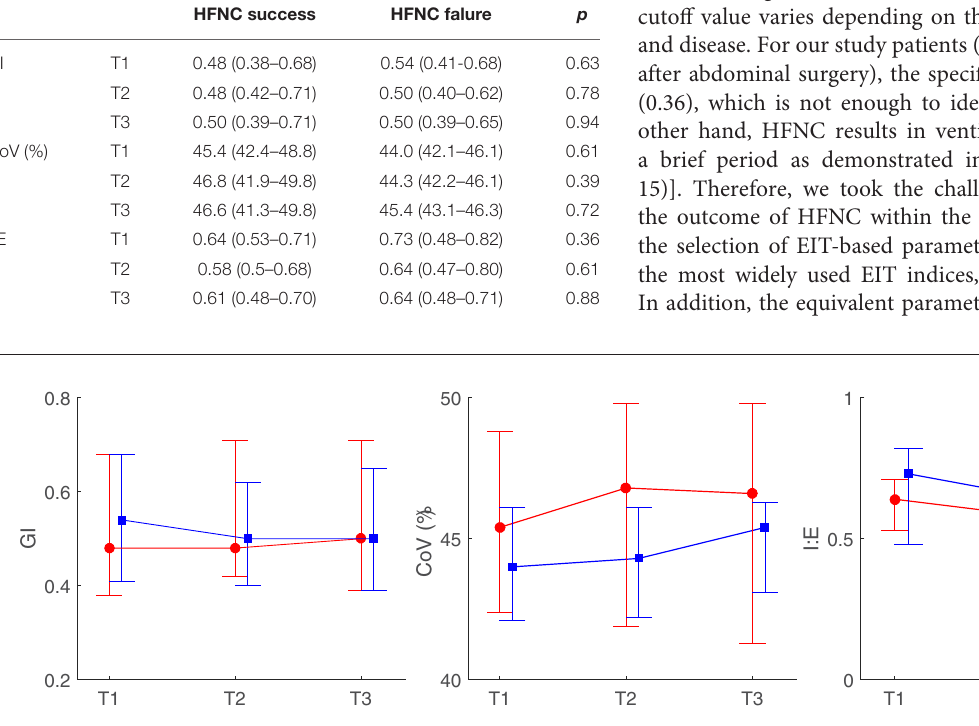
TABLE 3 | A summary of the absolute values of electrical impedance tomography (EIT)-derived parameters and the comparison between groups at different time points.